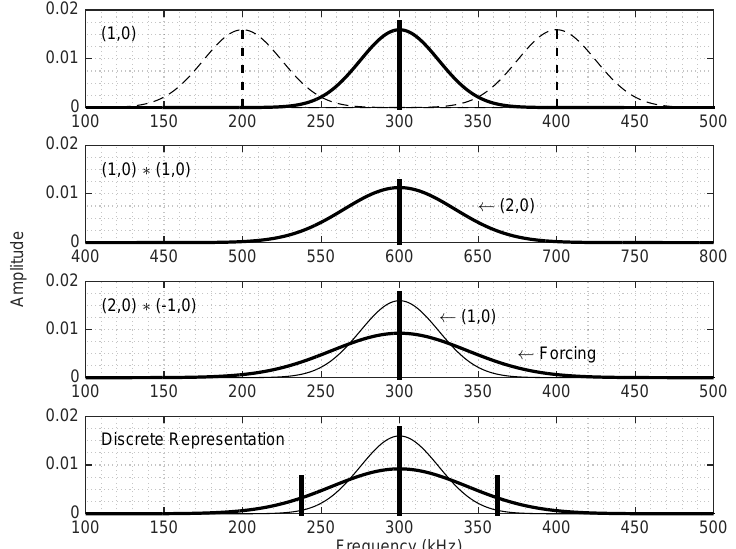
Figure 4. Illustration of quadratic nonlinear interactions for finite bandwidth